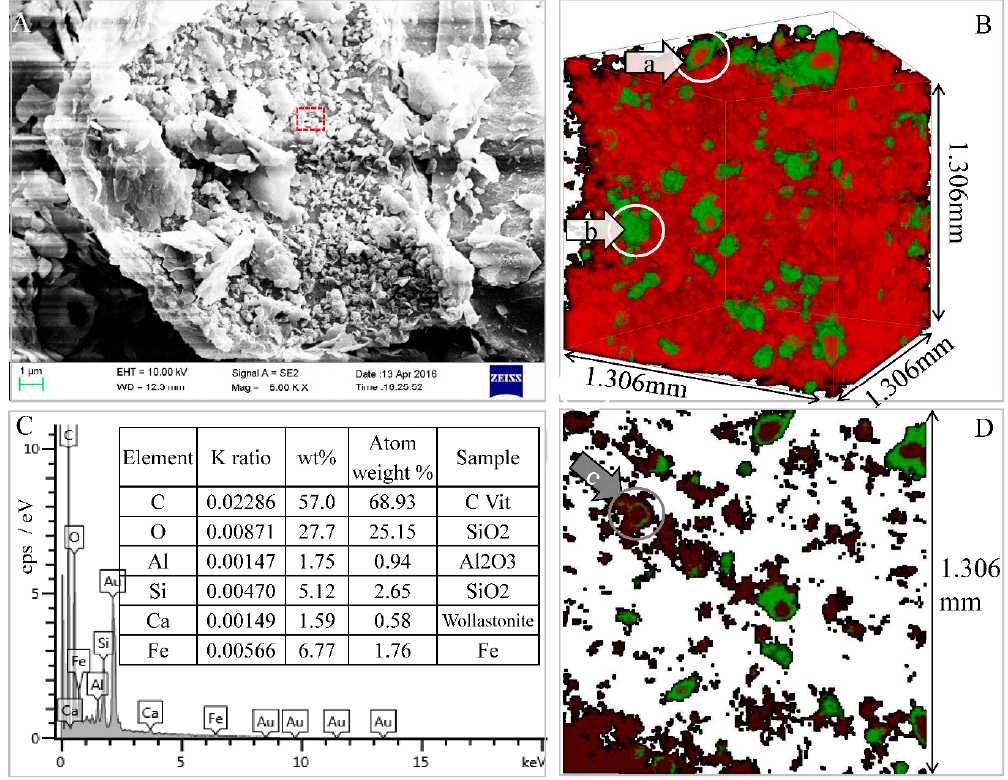
Figure 6. Coexistence of organic and clay mineral. ( A ) Amplifying SEM images of 5000×; ( B ) Structure of clay minerals and organic matter; ( C ) Elements in EDX energy spectra; and ( D ) 2D coexistence of organic and minerals (green and dark brown denote organic matter and a mixture of Minerals 1 and Minerals 2).